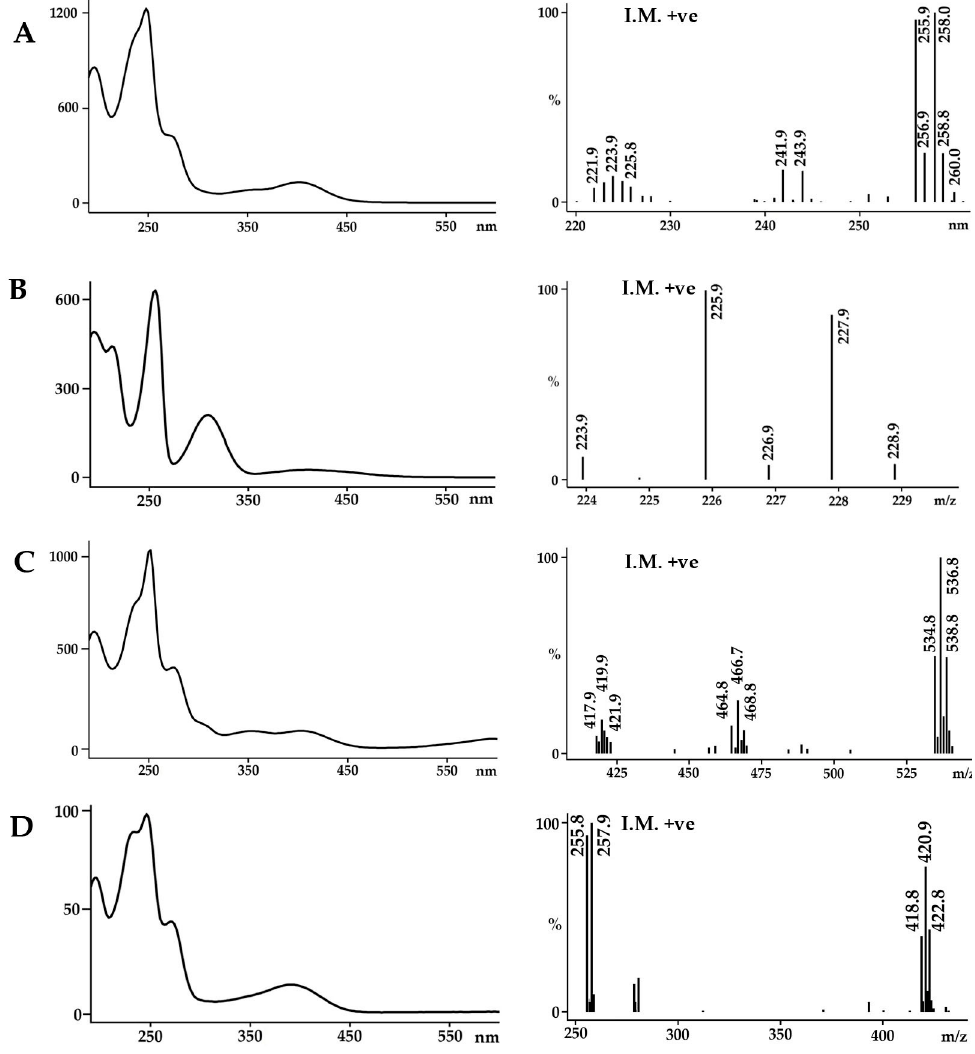
Figure 5. UV spectra ( left ) and mass spectra ( right ) for the intermediate precursors and end product found in the hypobranchial gland of Dicathais orbita from high performance liquid chromatography-mass spectrometry (HPLC-MS) with electrospray ionisation (ESI). The compounds are: ( A ) tyrindoleninone ( 5 ); ( B ) 6-bromoisatin ( 6 ); ( C ) tyriverdin ( 8 ); and ( D ) 6,6 ′ -dibromoindigo ( 9 ). I.M. ionisation mode: I.M. +ve = positive ions, I.M. − ve = negative ions.